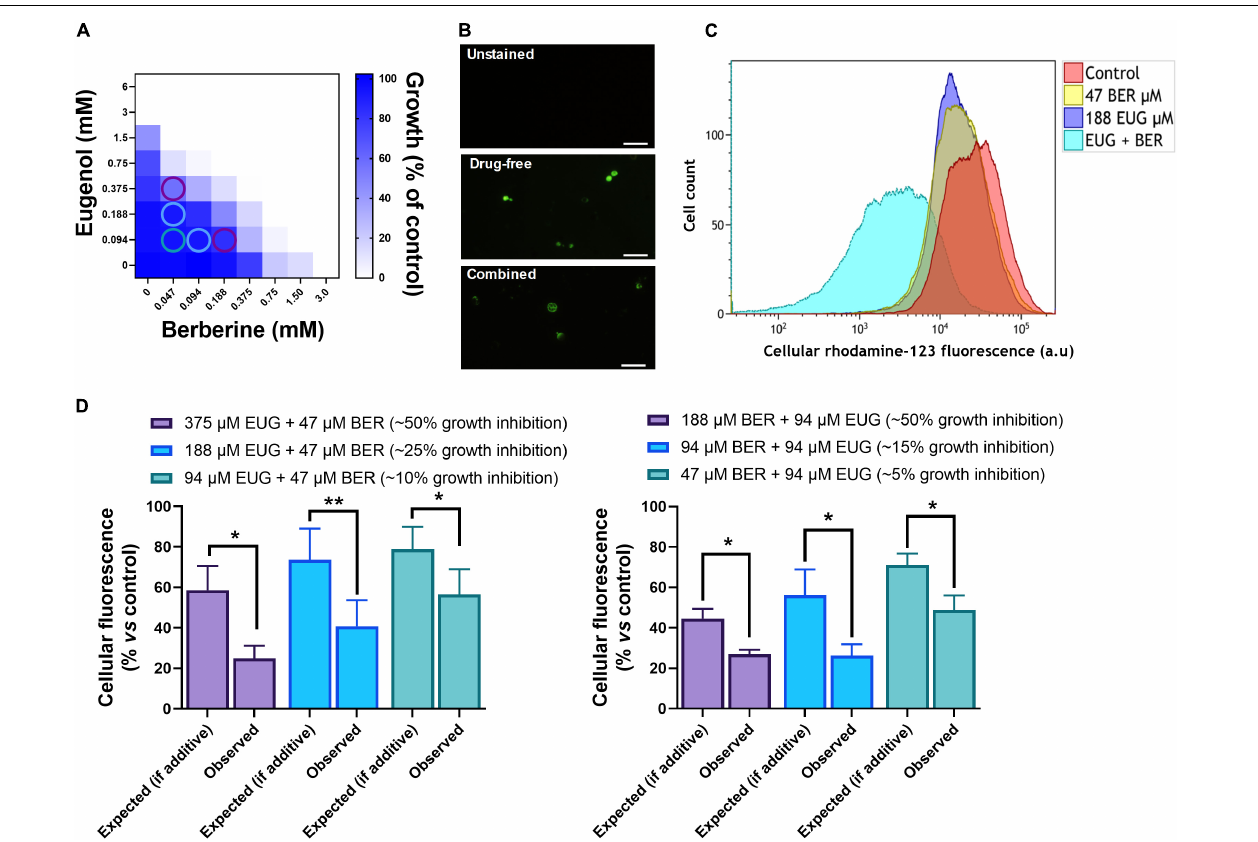
FIGURE 5 | Mitochondrial membrane depolarization in eugenol- and berberine-treated yeast cells. (A) Checkerboard assays of combinatorial growth effects were performed as described in Figures 1 , 4 . Combination concentrations that were subsequently tested for mitochondrial membrane depolarization are circled. (B) Microscopic imaging of S. cerevisiae cells treated with or without 94 µ M EUG and 188 µ M BER for 24 h, stained with rhodamine-123. Images were captured using a × 40 objective lens, through a FITC-filter; scale bar, 20 µ m. Images are representative of three biological replicates. (C) Flow cytometric histograms for cells incubated for 24 h without (control) or with the indicated concentrations of EUG and BER. Cells were then stained with rhodamine 123 before analysis of fluorescence; a.u., arbitrary units. (D) Observed effects of combinations were obtained experimentally from median fluorescence of rhodamine 123-stained cells exposed to the EUG + BER combination [derived from corresponding flow cytometric data as in panel (B) ], normalized to the no drug control (100%). Expected effects were calculated by multiplication of the % median-fluorescence determinations obtained for the corresponding individual-compound effects. Values represent means ± SEM from four independent experiments: ∗ p < 0.05 and ∗∗ p < 0.01 according to paired t -tests. EUG, eugenol; BER,